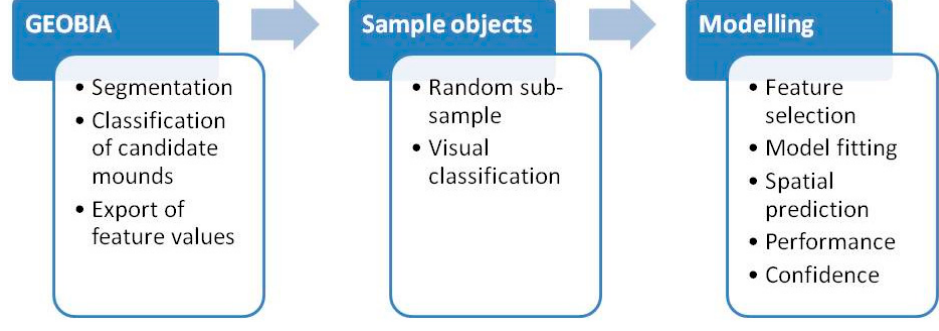
Figure 2. General work flow.